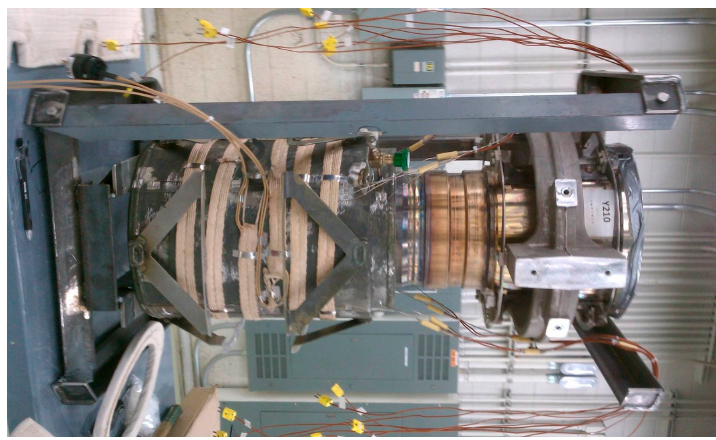
Figure 9. TES module test stand with induction heater ( top ) and TES module with heat tape and instrumentation attached ( bottom ). Table 1. Operating Conditions.